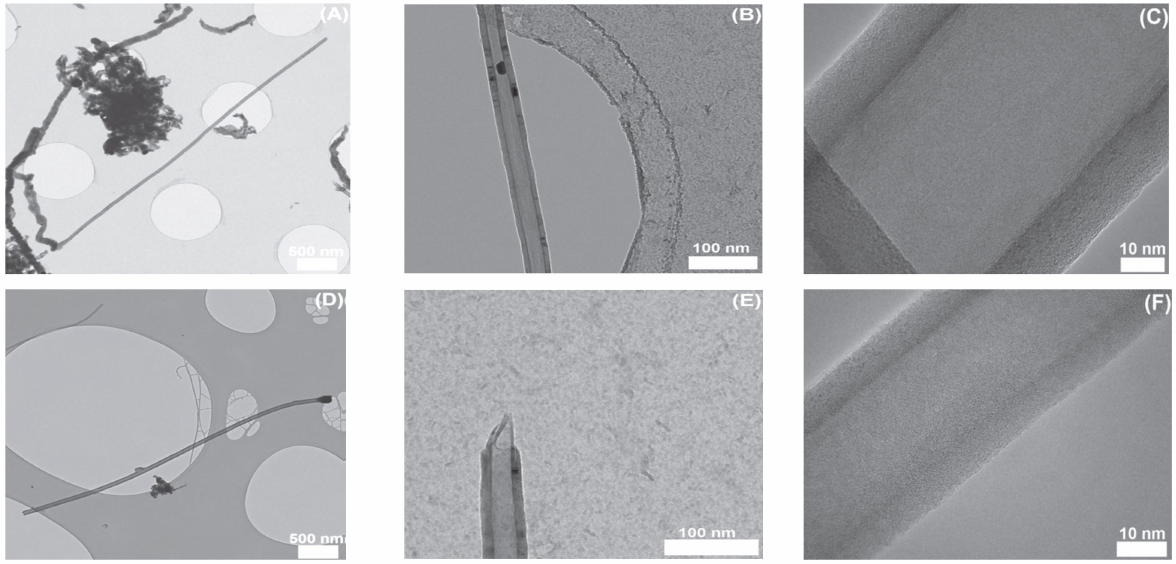
Figure 11. TEM images of sugarcane bagasse and pyrolysis temperatures of: 600 ◦ C ( A – C ); and 1000 ◦ C ( D – F ). Adapted with permission from Ref.